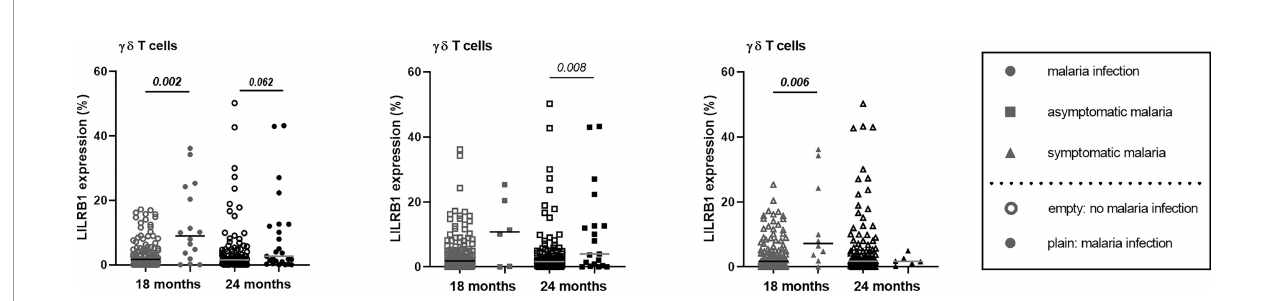
FIGURE 5 | Modulation of LILRB1 expression on gd T cell surface in infant with malaria infections. The expression of LILRB1 on immune cells was measured with the geometric mean of fl uorescence (gm fi ) in infants at 18 and 24 months of age. Empty circle, square and triangle (gray or black) represented infant without malaria infection at the sample collect. Plain circle, square and triangle (gray or black) represented infant with malaria infection, symptomatic malaria and asymptomatic infection, respectively. The horizontal dark line in the beeswarm plot represents the median value. Respectively 16 and 25 Pf infections were reported at 18 and 24 months among which 10 and 6 were symptomatic Pf infections. P-values in bold were the one that were still considered signi fi cant after Bonferroni